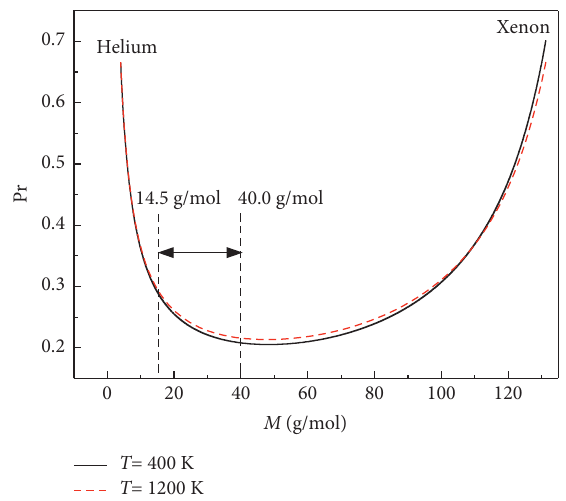
Figure 1: Variation of Prandtl number for helium-xenon gas mixtures at P �